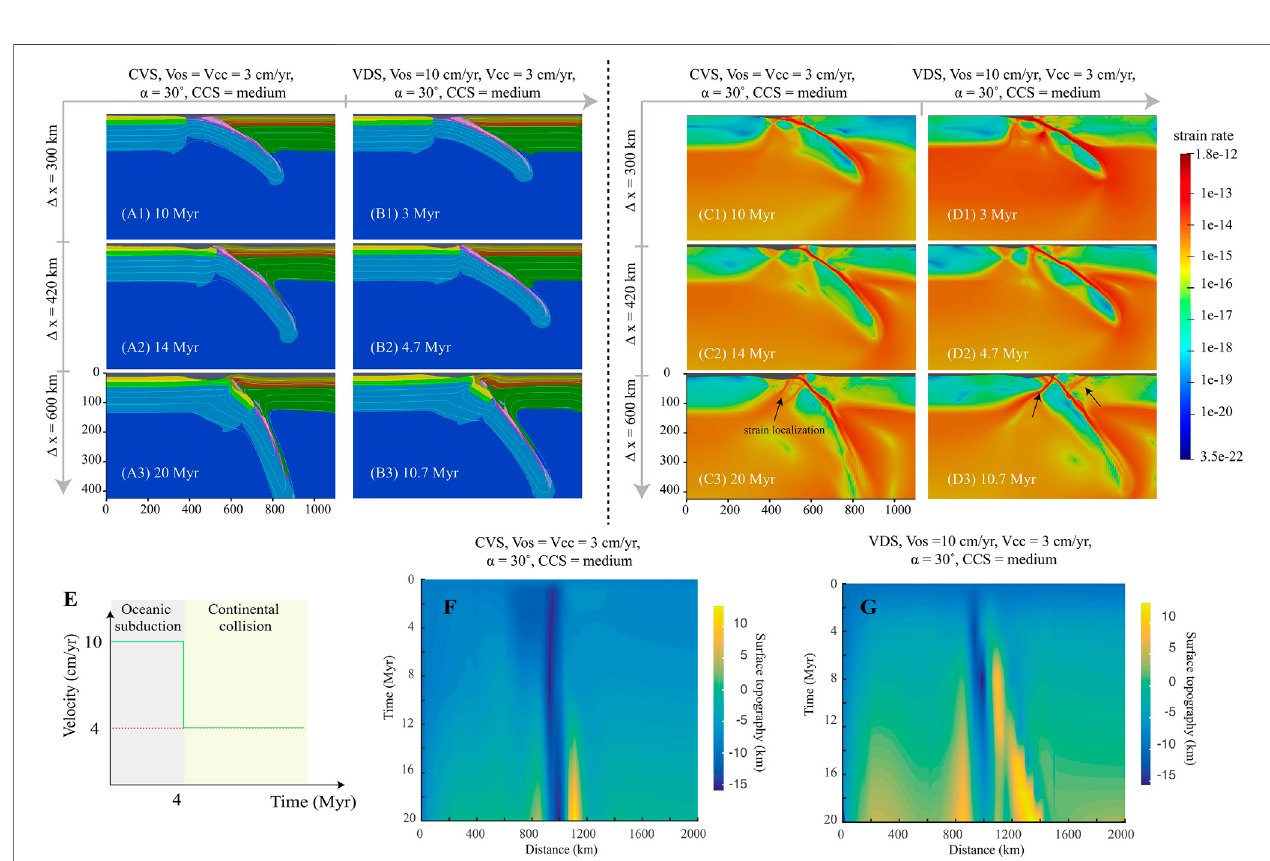
FIGURE 3 | The upper left panel shows the snapshots of compositional fi elds from models MSII-ca1 (CVS) (A1 – A3) and MSI-v1a1 (VDS) (B1 – B3) , respectively. Different colors denote different lithologies (see Figure 2 ). White lines denote isotherm with 200 ° C increment that start from 200 ° C to 1,200 ° C. The upper right panel showsthesnapshotsofstrainratefrommodelsMSII-ca1 (C1 – C3) andMSI-v1a1 (D1 – D3) . Δ xistheamountofconvergence. (E) showsthevelocityboundaryconditions of CVS (red dotted line) and VDS (green dotted line). (F) and (G) show the topography evolution of both models.